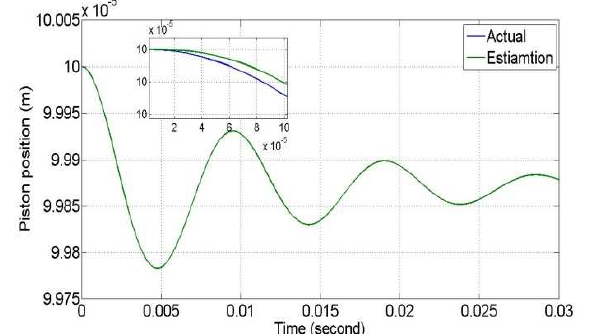
Fig. 2. Open loop piston position